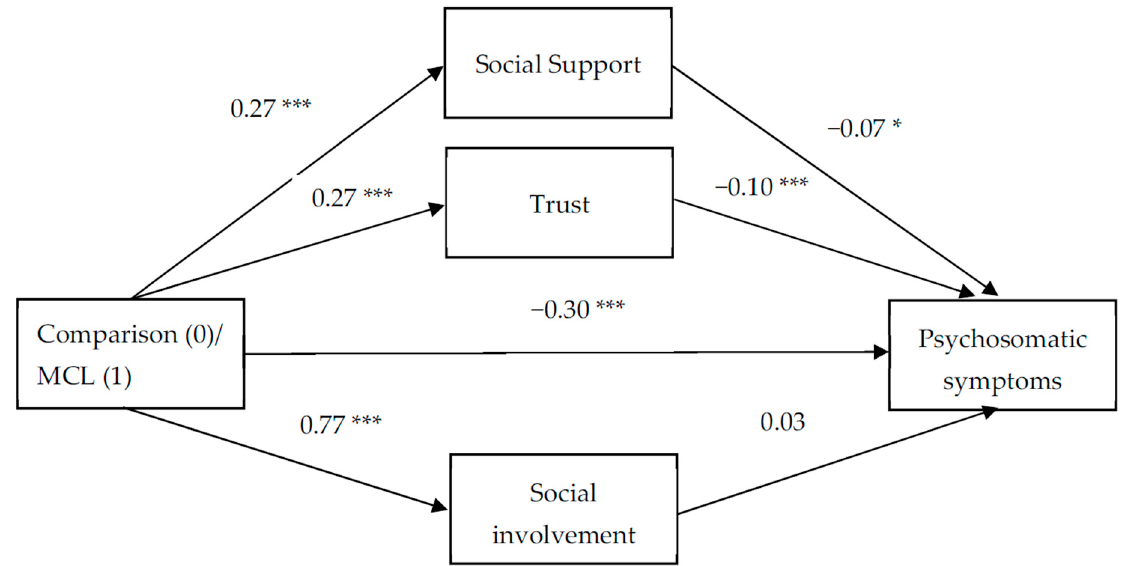
Figure 3. The mediation effect of social capital components on the link between participation in the Mamanet Cachibol League and psychosomatic symptoms (unstandardized coefficients) . * p < 0.05; *** p < 0.001